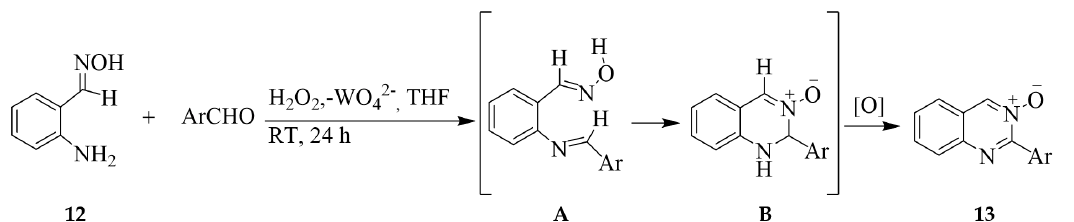
Scheme 5. One-pot synthesis of quinazoline 3-oxides from 2-aminobenzaldoxime and benzalde- hyde